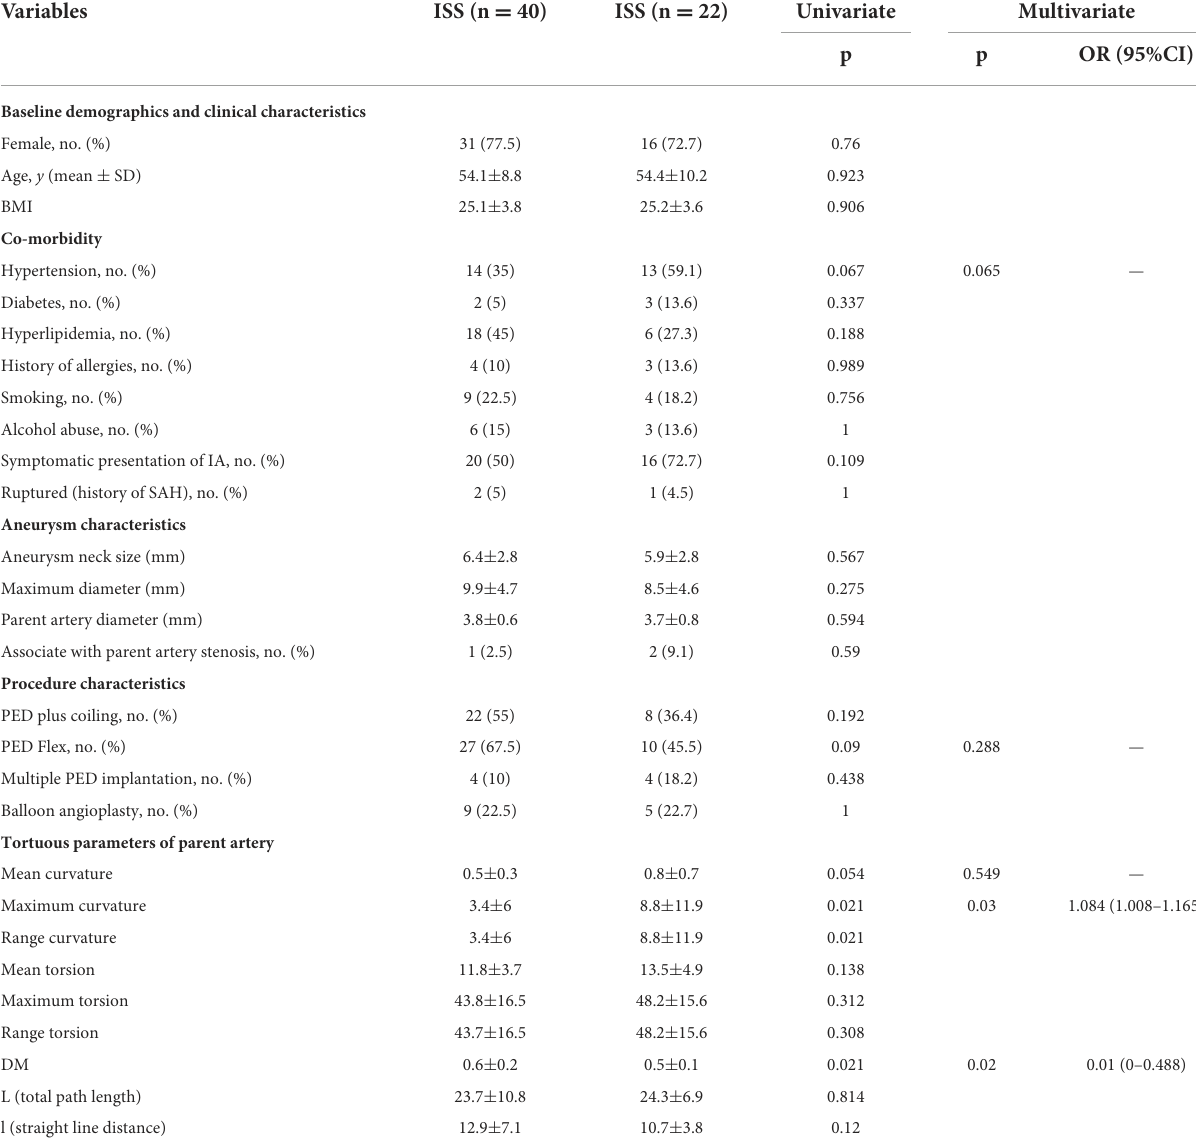
TABLE 2 Univariate and multivariate logistic analysis in association with ISS. Variables ISS (n = 40) ISS (n = 22) Univariate Multivariate